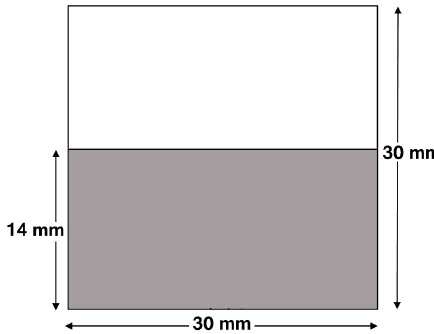
Figure 3. The bottom view of the truncated ground